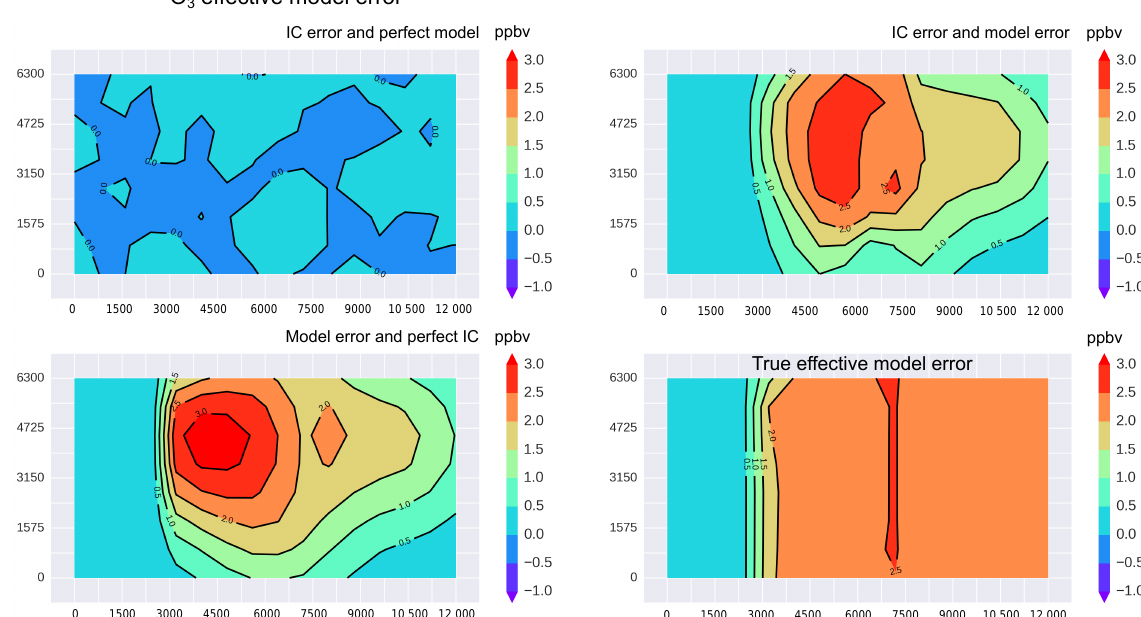
Figure 9. Temporal averages (24h) of the estimated effective model error for the three experiments as in Fig. 8. From left to right and from top to bottom, experiments (i), (ii) and (iii) are shown. On the bottom right plot the true effective model error in the experiments (ii) and (iii) is shown (no model error was activated for the first